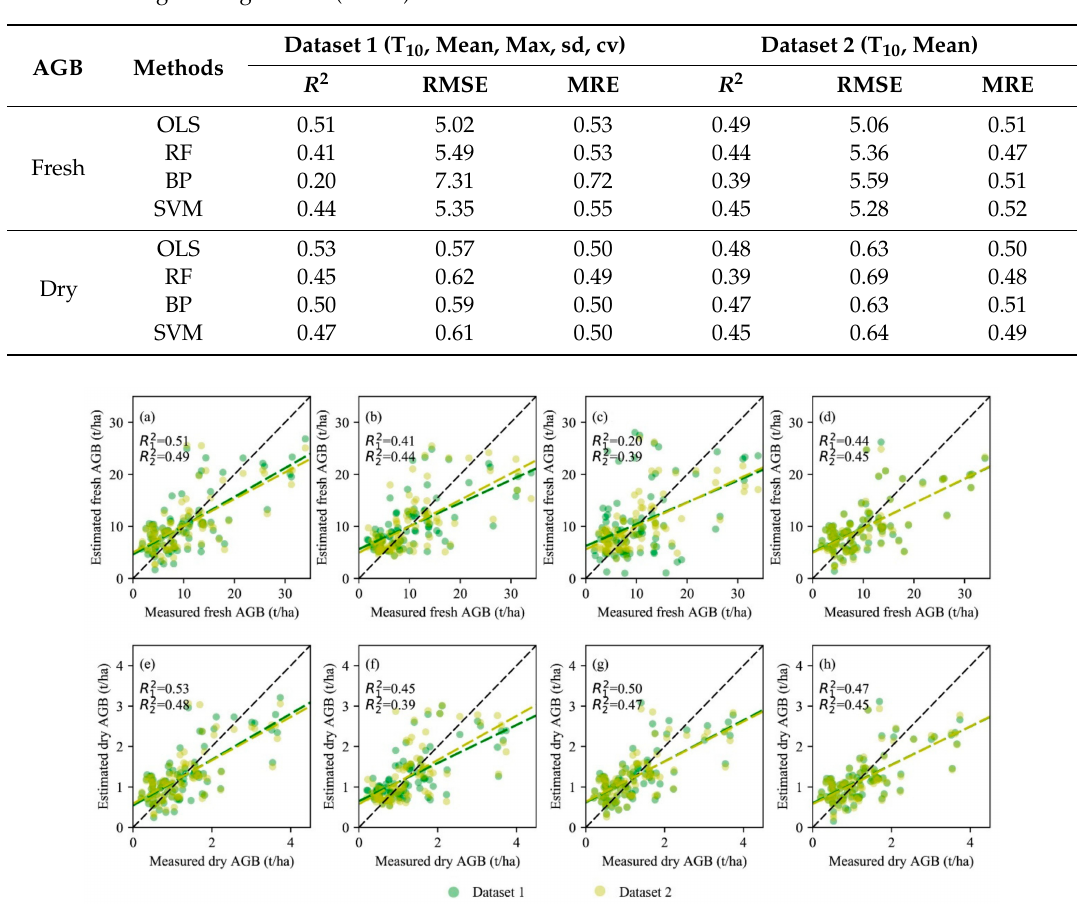
Figure 8. Comparisons of measured AGB and estimated AGB of maize via the four methods based on Dataset 1 (green spots) and Dataset 2 (yellow spots), which were derived from the multiSPEC-4C SfM point clouds: ( a – d ) the traditional multi-variable linear regression model (OLS), random forest (RF), backpropagation neural network (BP), and support vector machine (SVM) methods for the AGB estimation of fresh maize; ( e – h ) OLS, RF, BP, and SVM for the AGB estimation of dry maize. R 1 2 and R 2 2 represent the coe ffi cients of determination for a linear regression model between the measured and estimated AGB using Datasets 1 and 2,